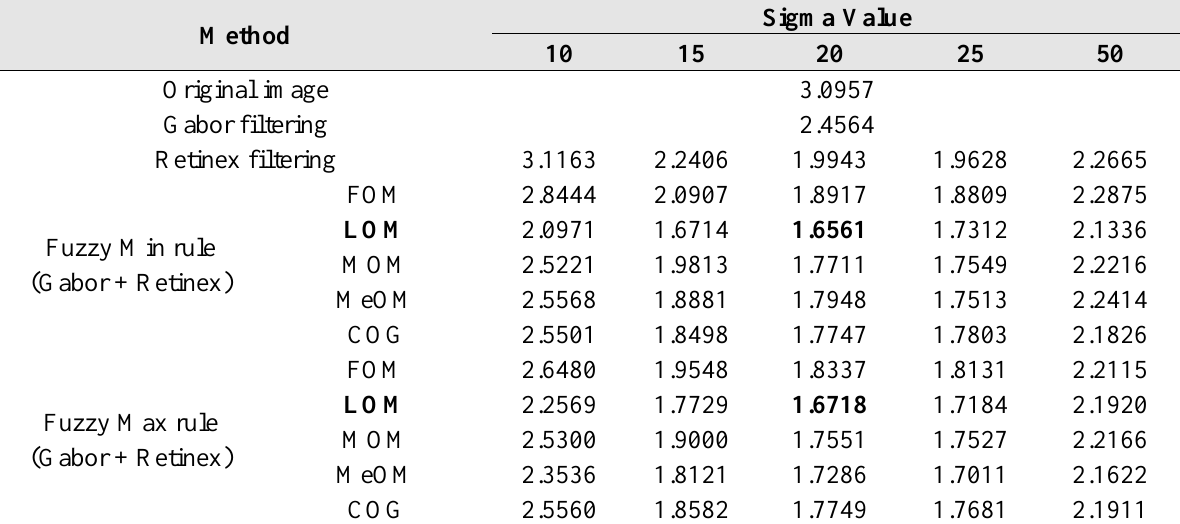
Table 4. Recognition accuracy using the proposed method with Gabor filtering and Retinex filtering, with various sigma values, and a LBP operator in terms of EER for images from database I (unit: %).